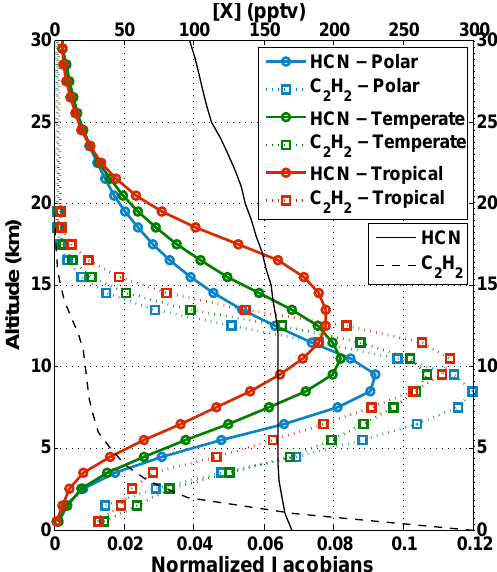
Figure 3. Normalized Jacobians of the forward model implemented in Atmosphit for HCN (solid lines) and C 2 H 2 (dotted lines) and for the standard modelled polar (blue lines), temperate (green lines) and subtropical (red lines) atmospheres. These are averaged Jaco- bians over the spectral ranges 645–800cm − 1 for HCN and 645– 845cm − 1 for C 2 H 2 . Are also plotted the HCN (black line) and C 2 H 2 (black dashed line) vertical distributions in a standard tem- perate atmosphere.